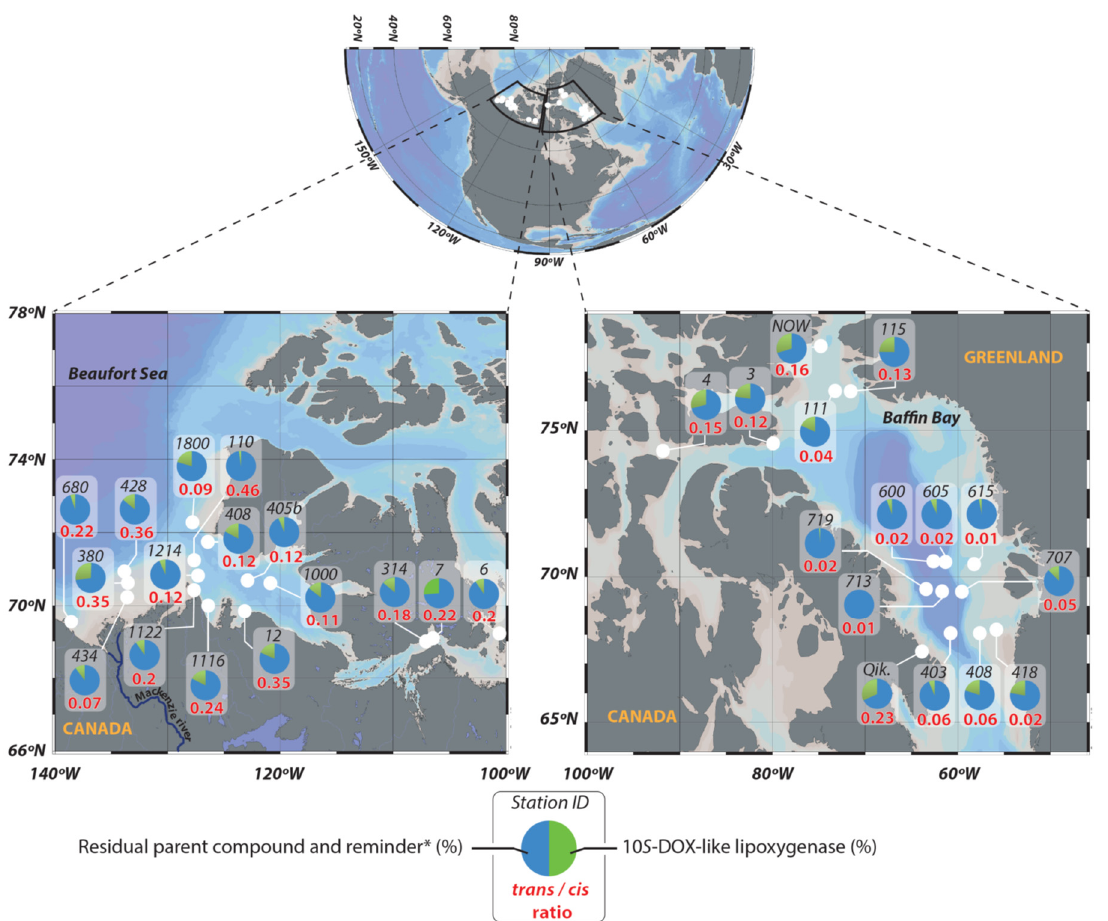
Figure 1. Map of the station investigated in the Beaufort Sea and Baffin Bay. The pie charts show the percentage of residual parent compounds (palmitoleic acid) degraded by the 10 S -DOX. In red, the trans/cis vaccenic acid ratio. Qik stands for Qikiqtarjuaq. (*) abiotic